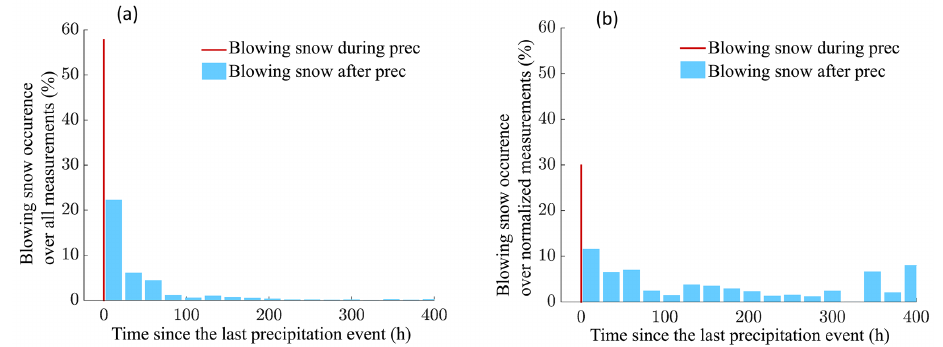
Figure 8. (a) Time between blowing snow and the last precipitation event at PE station. The red bar represents blowing snow occurring during precipitation, and the blue bars represent the fraction of blowing snow occurring each 24h time lag after a precipitation event. (b) Ratio of the number of blowing snow hours happening within the time lag over the total number of measurements for this time lag.